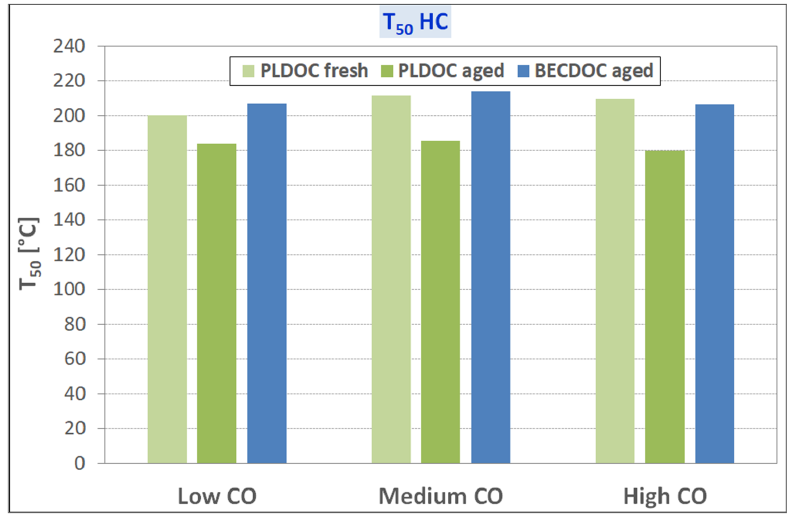
Figure 12. DOC light-off test: T 50 (HC)—average values.